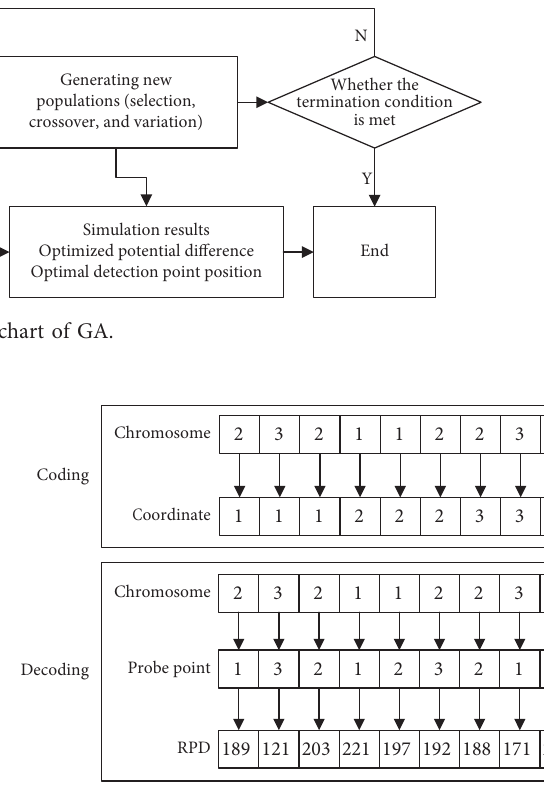
Figure 7: The specific implementation process of encoding and